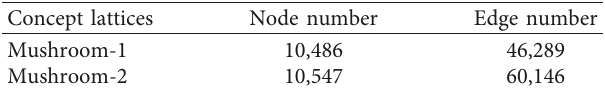
Figure 3: The structural characteristics of cube lattices on Foodmart-1w and Weather-1w. (a) Degree distribution. (b) Clustering coefficient. (c) Average path length. Table 4: The second group